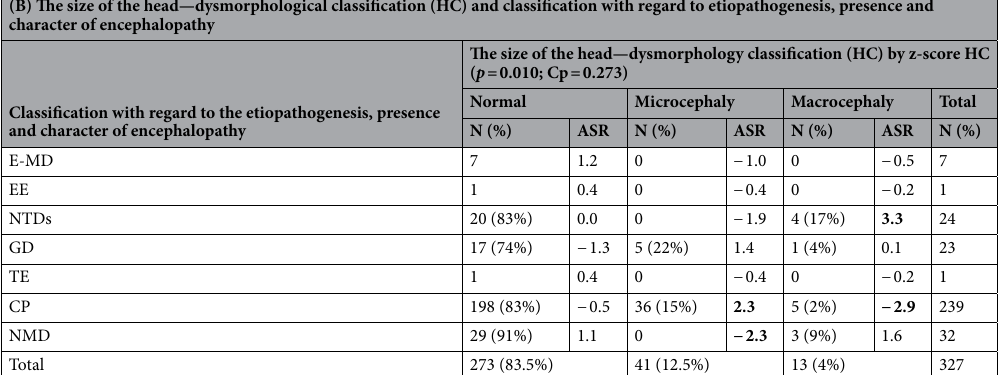
Table 2. The size of the head—dysmorphological classification (HC) and (A) units and syndromes associated with neurodysfunction, (B) classification with regard to the etiopathogenesis, presence and character of encephalopathy. N numbers of patients; % percent; p probability value calculated by chi-square test of independence; Cp Pearson’s Contingency Coefficient C, Cp ≥ 0, values distant from 0 reflect some relationship, values approaching 1 correspond to a perfect association; ASR adjusted standardized residuals, values > 1.96 reflect a greater number, and those below < − 1.96 correspond to a smaller number than a random